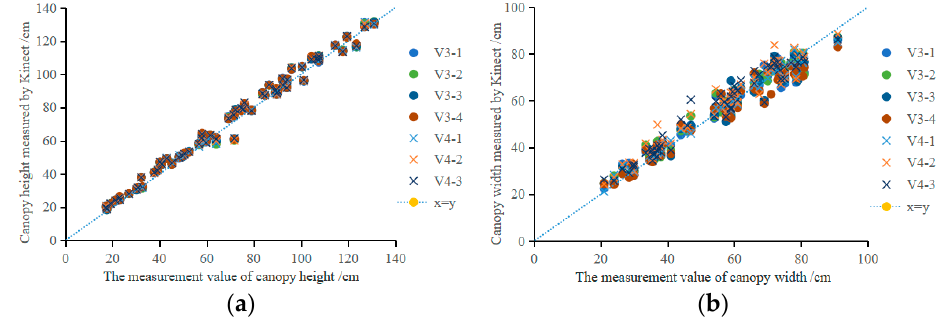
Figure 13. The results of canopy height and width: ( a ) calculated and measured values of canopy height; ( b ) calculated and measured values of canopy maximum width.